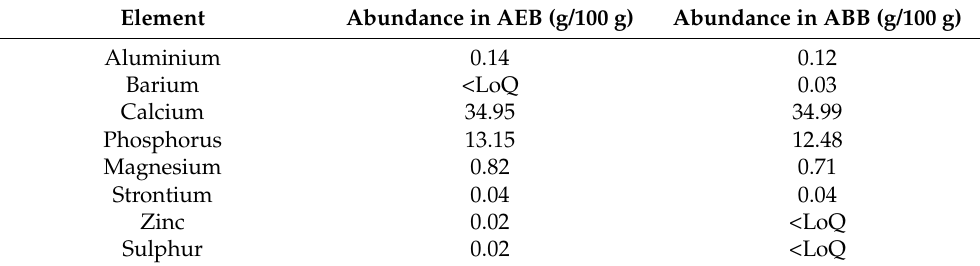
Figure 4. The XRD spectra obtained for ABB ( top ) and AEB ( bottom ). Both biomaterials show the typical peaks of hydroxyapatite. Table 1. Abundance of the elements detected by XRF in the two samples. Limit of quantification (<LoQ) was 0.01 g/100